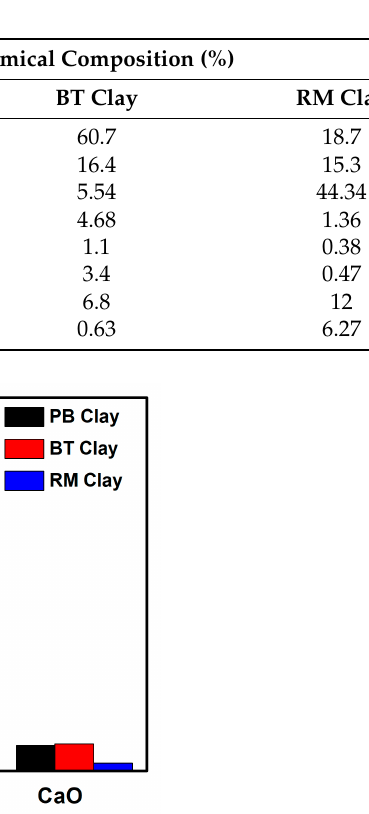
Table 1. Chemical composition of NICs clay.